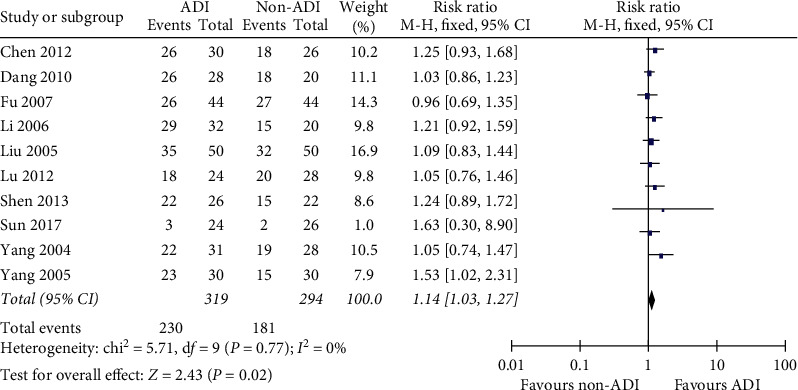
ADI increased ORR in advanced BC patients as an add-on therapy (RR = 1.14, 95% CI 1.03–1.27; chi2 = 5.71, P=0.77; I2 = 0%).